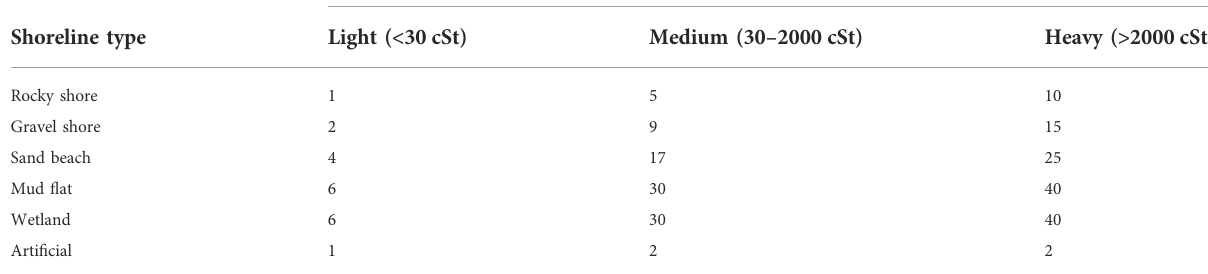
TABLE 2 Maximum surface oil thicknesses for various beach types as function of oil viscosity (Etkin et al.,